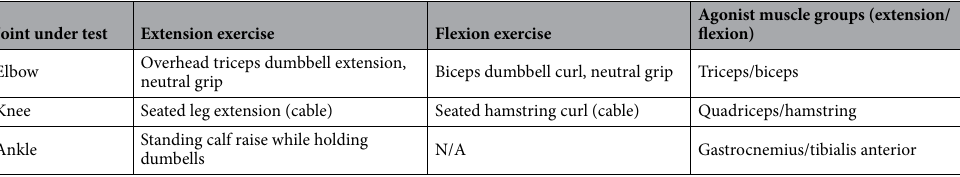
Table 1. Exercises, along with agonist and antagonist muscle